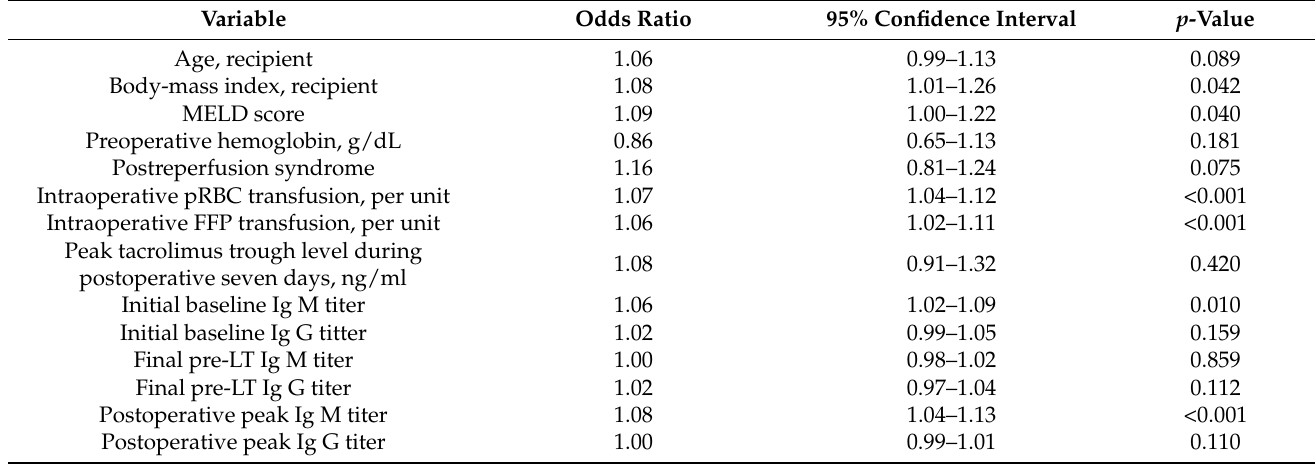
Table 2. Multivariable logistic regression analysis for acute kidney injury after liver transplantation.